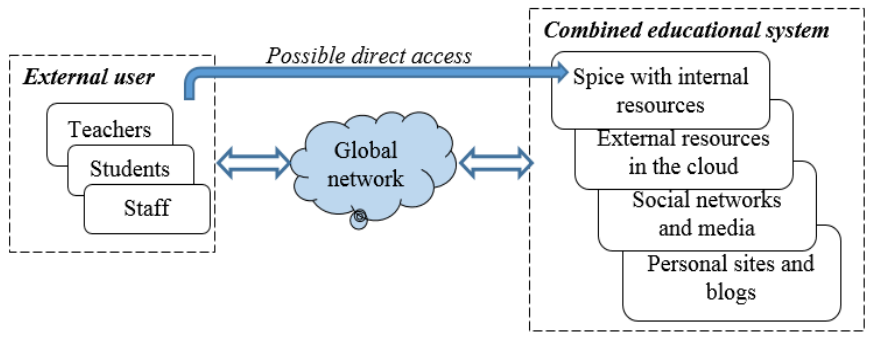
Figure 1. Conceptual model for a combined e-learning environment.